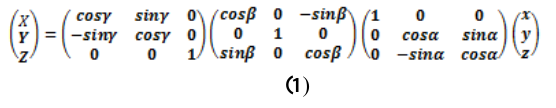
Vertical Deformation [Size of the circle]